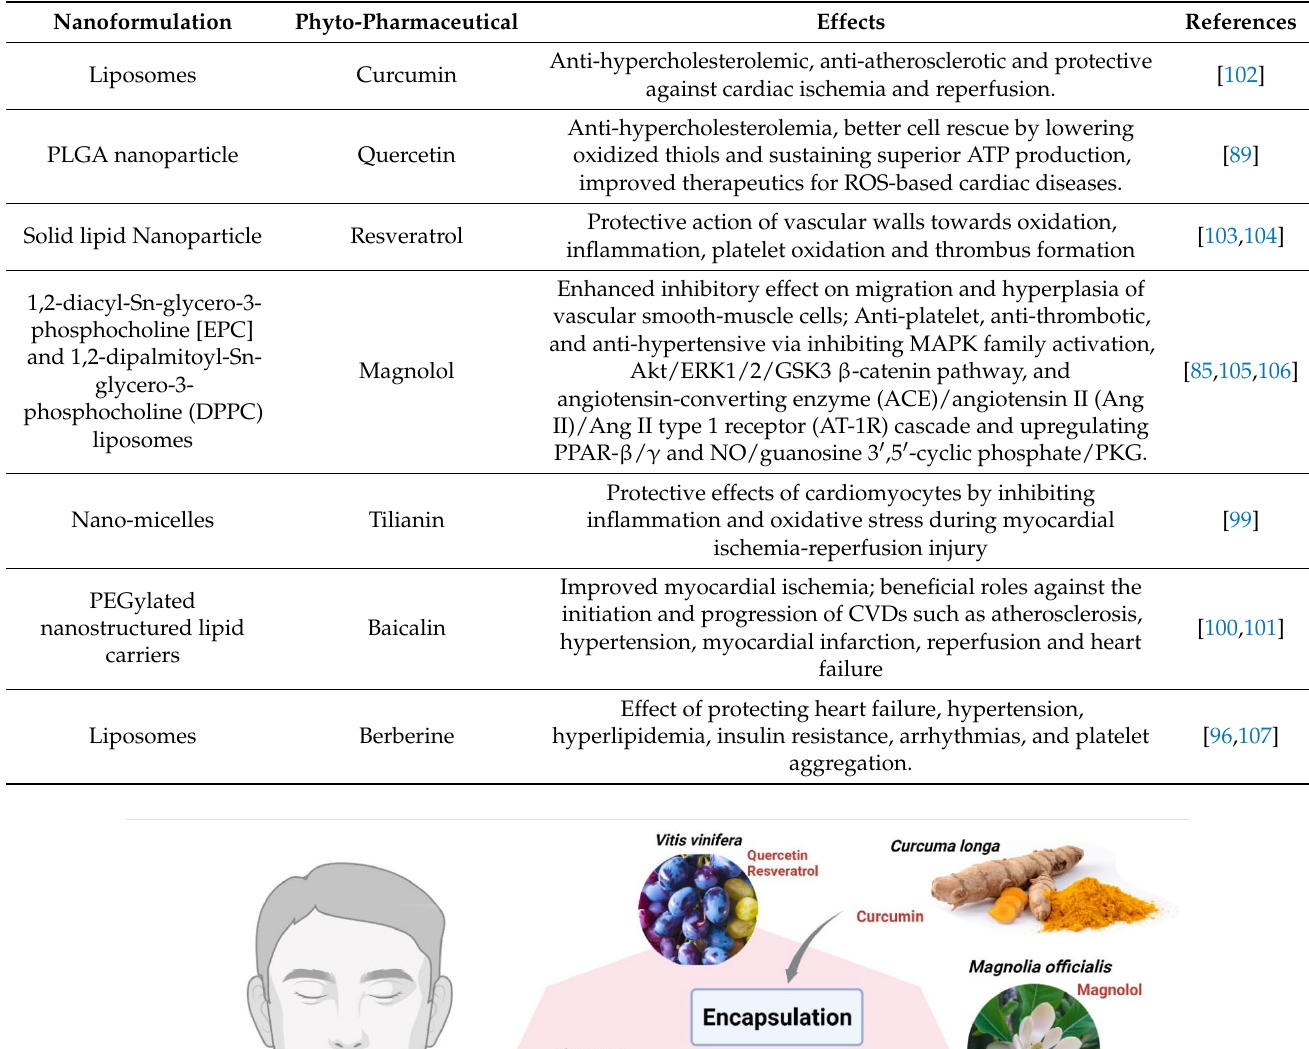
Table 2. Nano-phytopharmaceuticals for therapeutic applications in CVDs.